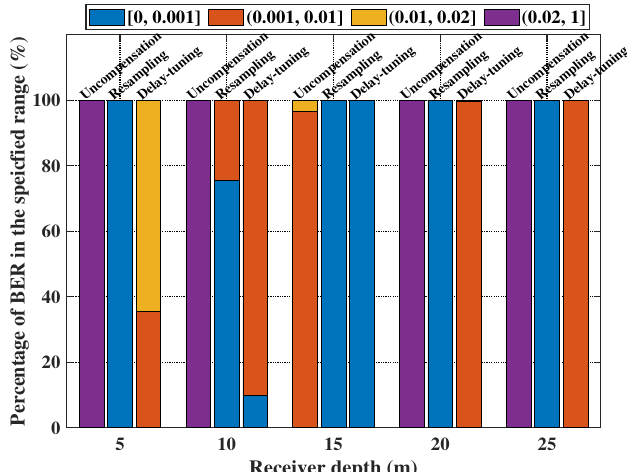
Figure 7. The BER outputs of different communication schemes under different data rate conditions at Doppler = − 8 Hz.